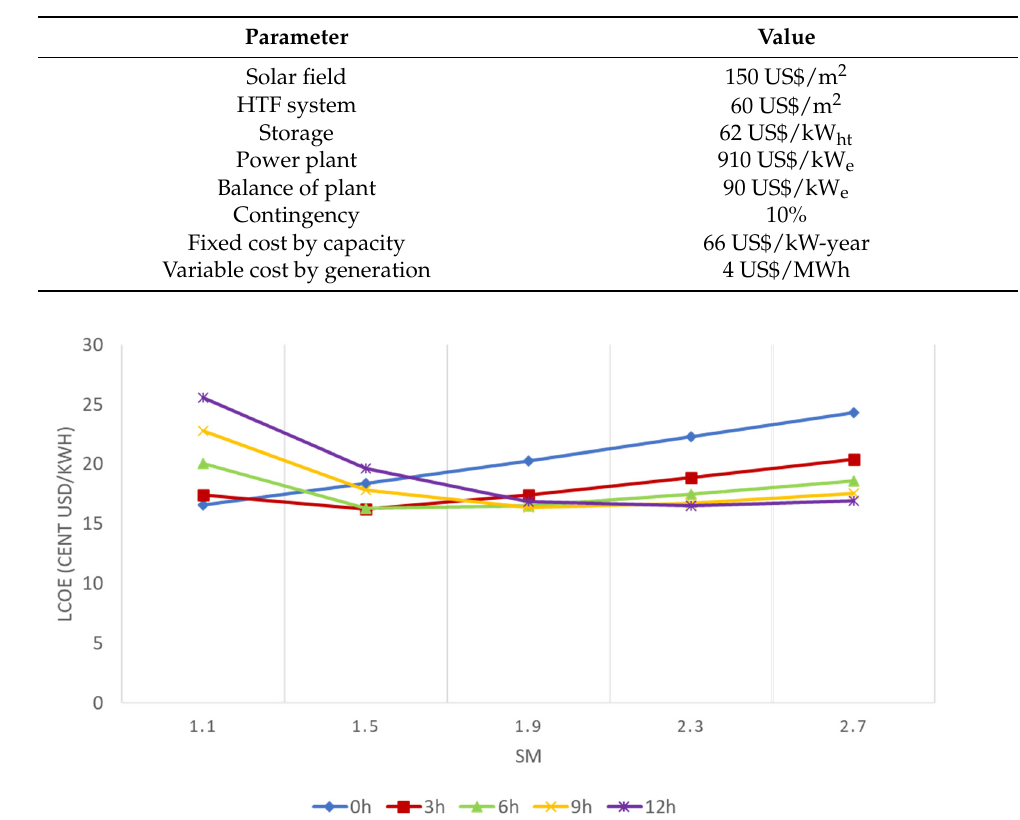
Table 4. Specific costs of PTC technology [38].